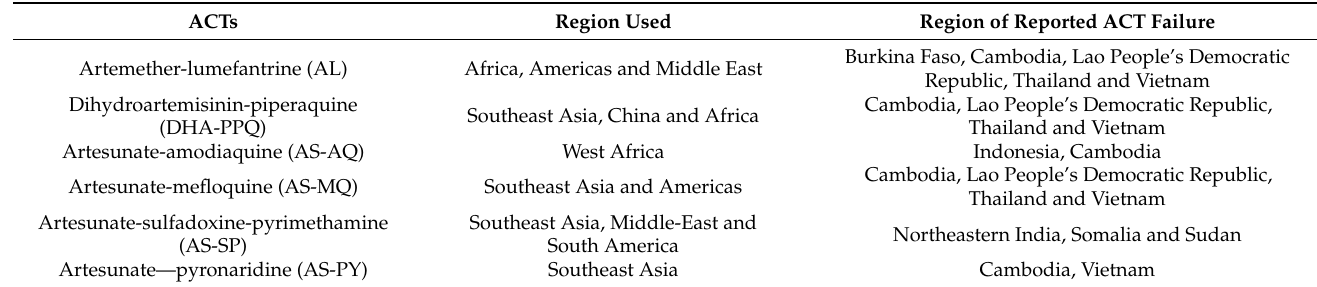
Table 2. Artemisinin-based combinations therapies (ACTs) against P. falciparum recommended by the WHO